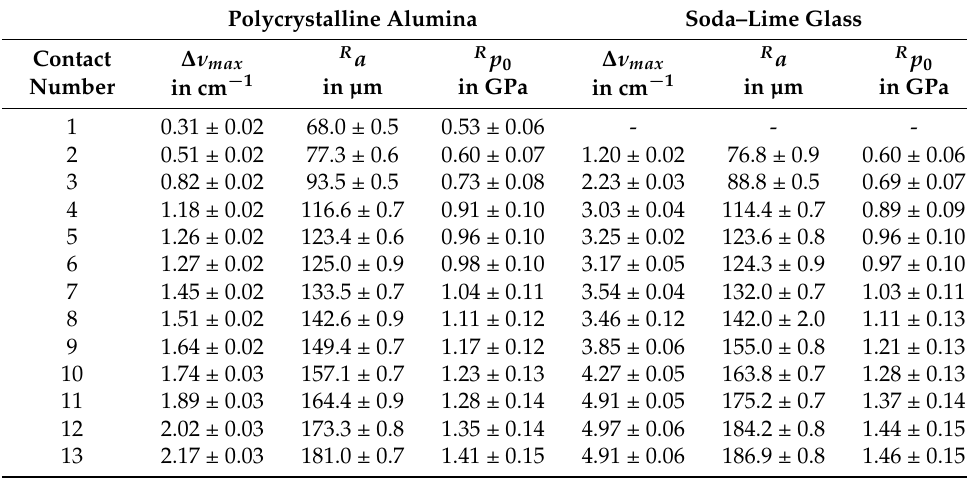
Table 4. Maximum Raman shift ∆ ν max , radii R a and maximum contact pressures R p 0 deduced from spectral